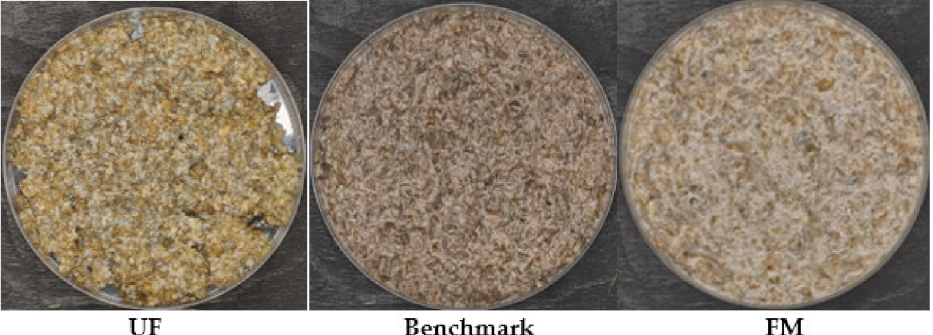
Figure 1. Appearance of unfermented rye bran and wheat germ mixture (UF) and of the preferment obtained by the fermentation of the selected microbial consortia (FM) and the benchmark after 24 h of